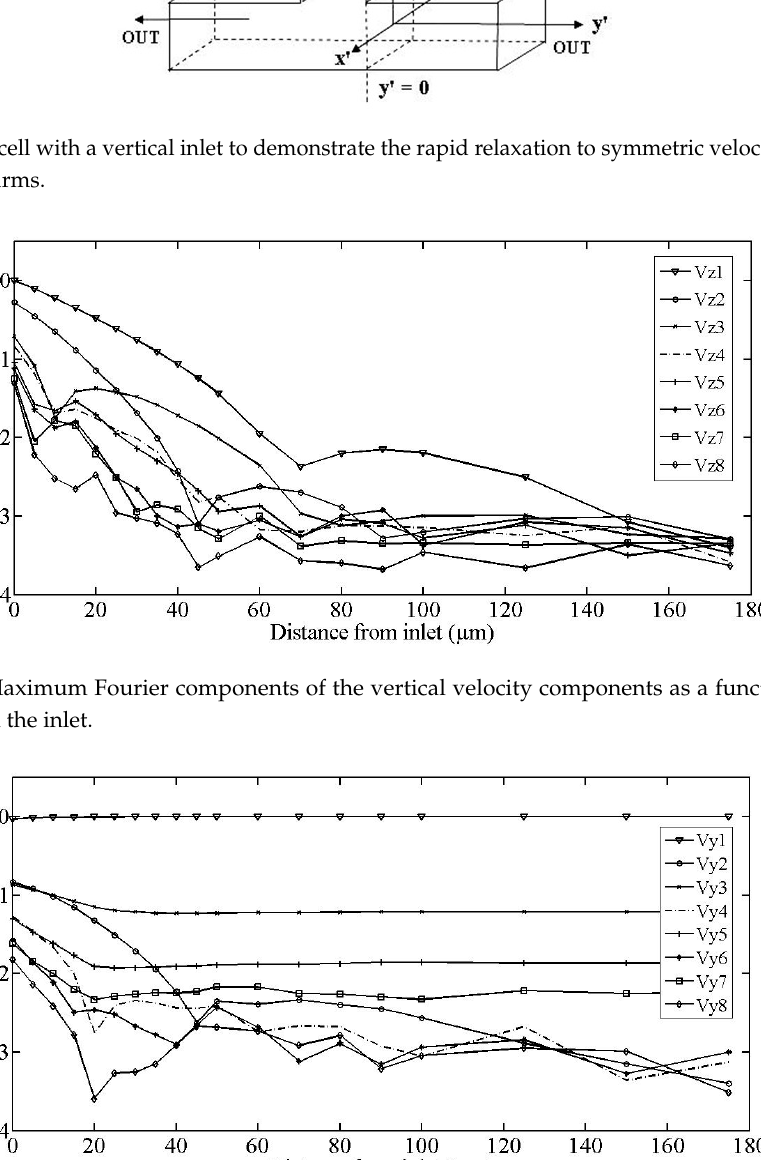
Figure A3. Maximum Fourier components of the axial velocity components as a function of the distance from the inlet.